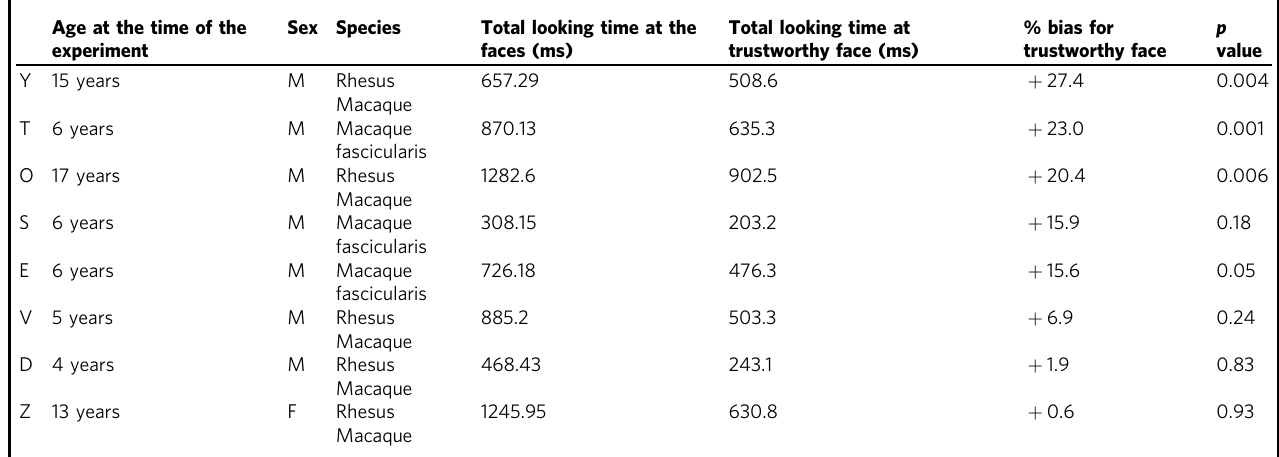
Table 1 Monkeys ’ individual biographical and behavioral